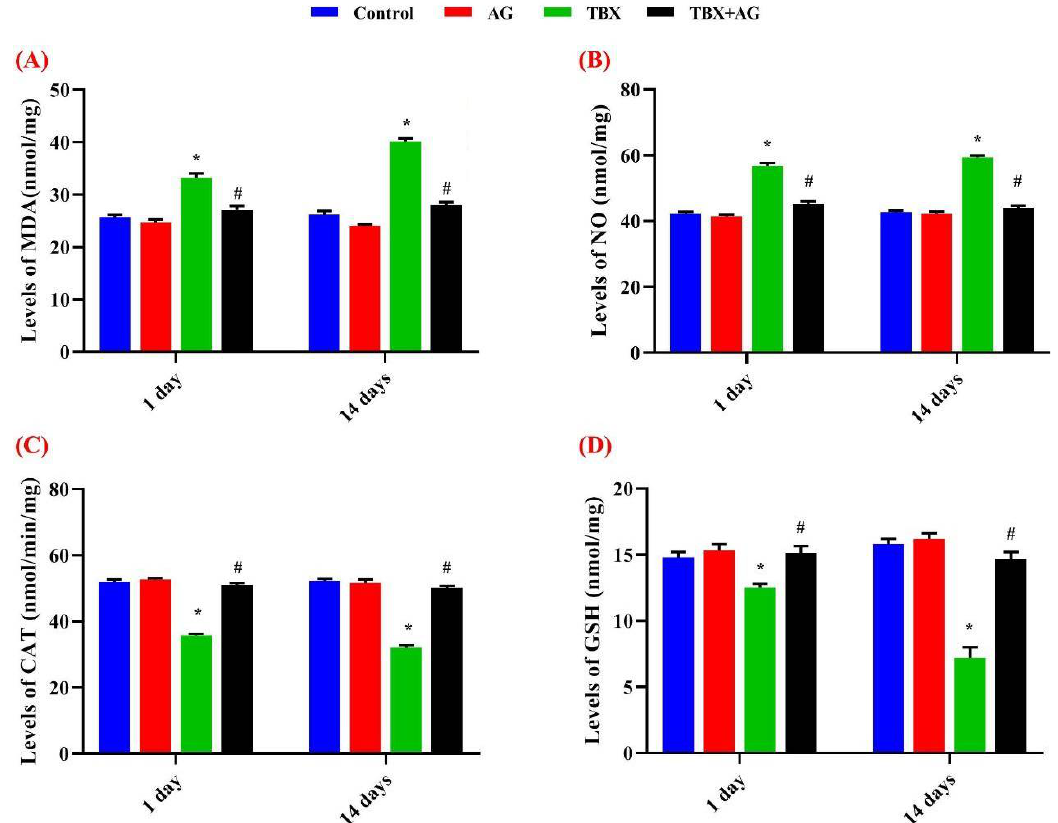
Figure 2. The protective effect of AG against TBX-induced alterations in oxidative stress markers after 1 and 14 days of treatments. ( A ) MDA: malondialdehyde, ( B ) NO: nitric oxide, ( C ) CAT: catalase and ( D ) GSH: glutathione. *: Significant ( p < 0.001) relative to untreated groups. #: Significant ( p < 0.001) relative to TBX-treated groups. Data were represented as mean ± SE of three independent experiments ( n = 5). AG: 10% Arabic gum, TBX: Telebrix (1600 mg I/kg b.wt.) and TBX+AG: co-treatment with 1600 mg/kg b.wt. and 10% Arabic gum.